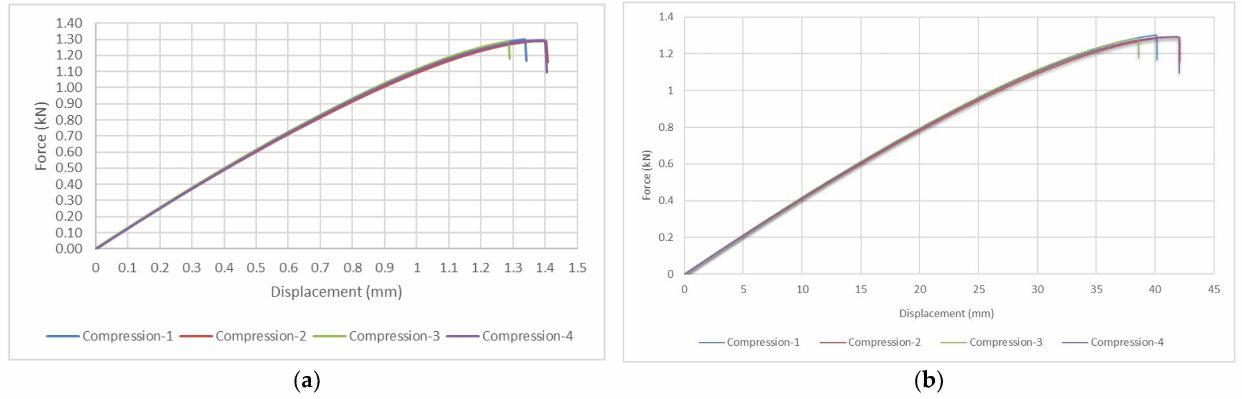
Figure 18. CPE honeycomb compression tests: ( a ) Force-displacement graphical evolution ( b ) Force- time graphical evolution.